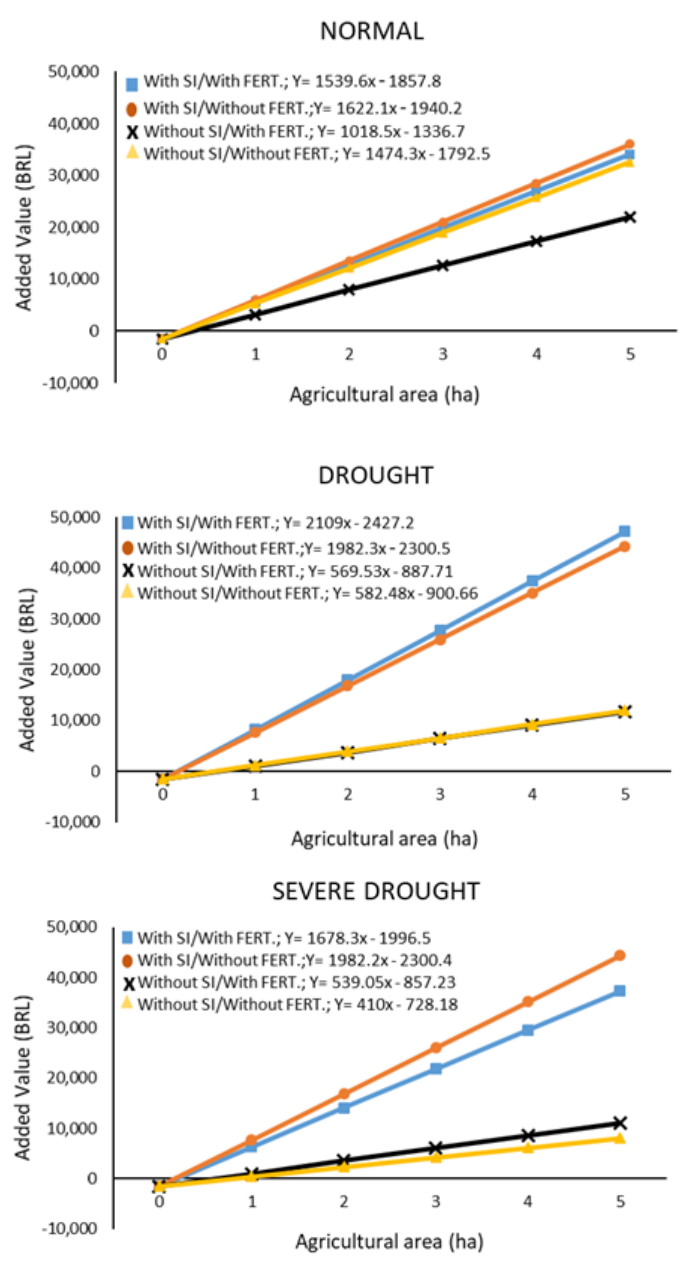
Figure 3. Added value for the different simulated water scenarios, supplemental irrigation (SI) with treated wastewater, and presence and absence of NPK fertilization, as a function of the area cultivated with BRS 433 cotton.